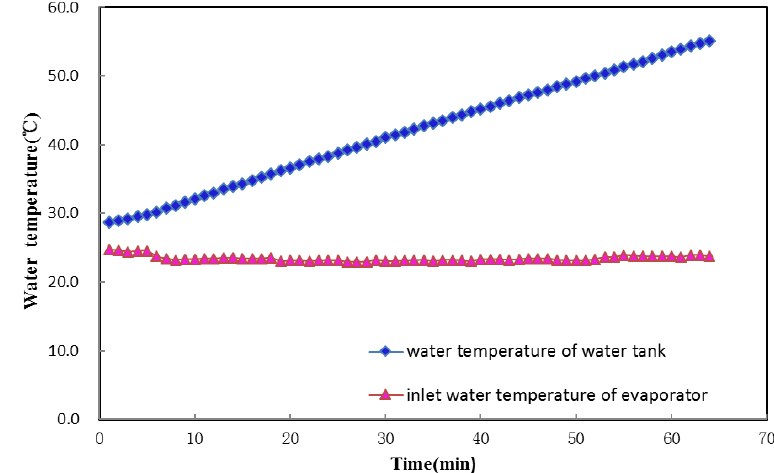
Figure 2. Variations of water temperature with heating time.